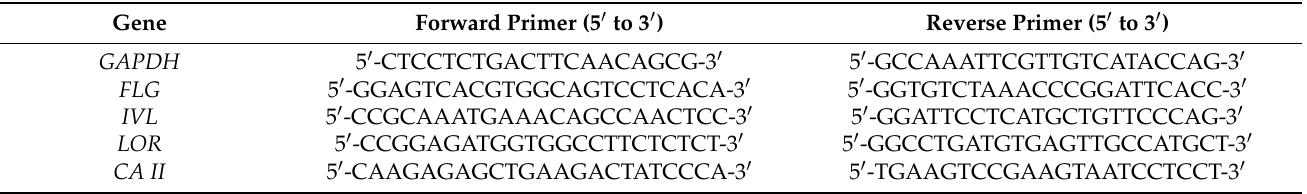
Table 1. Sequences of forward and reverse primers used for qPCR